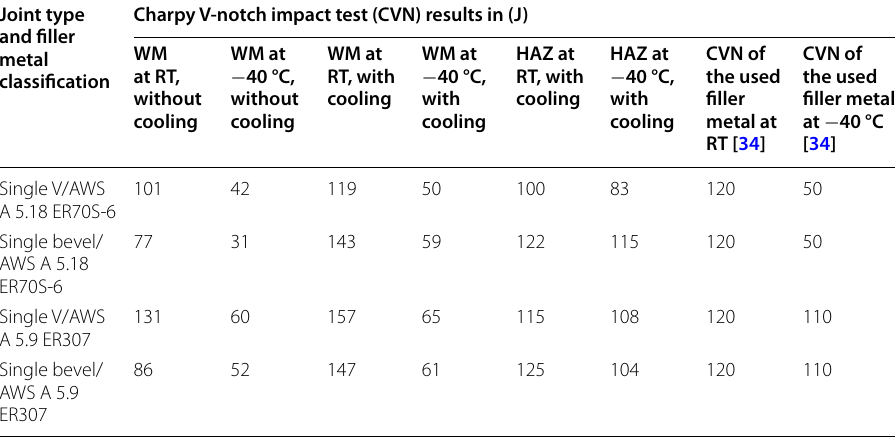
Table 10 Charpy V-notch impact properties of welded